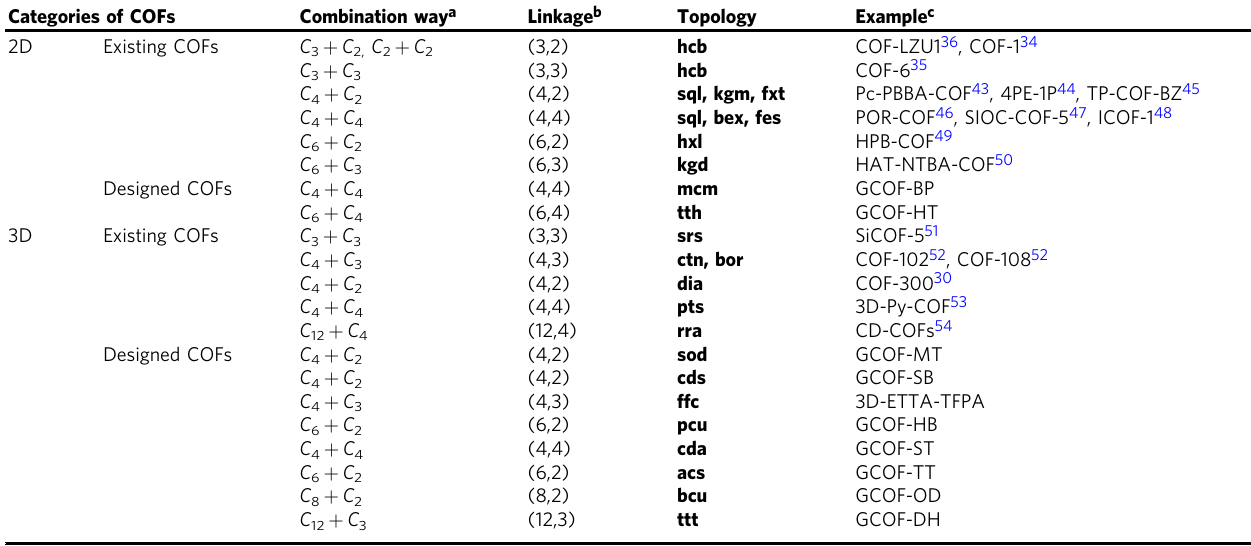
Table 1 Structural information of the existing and designed COFs in our database Categories of